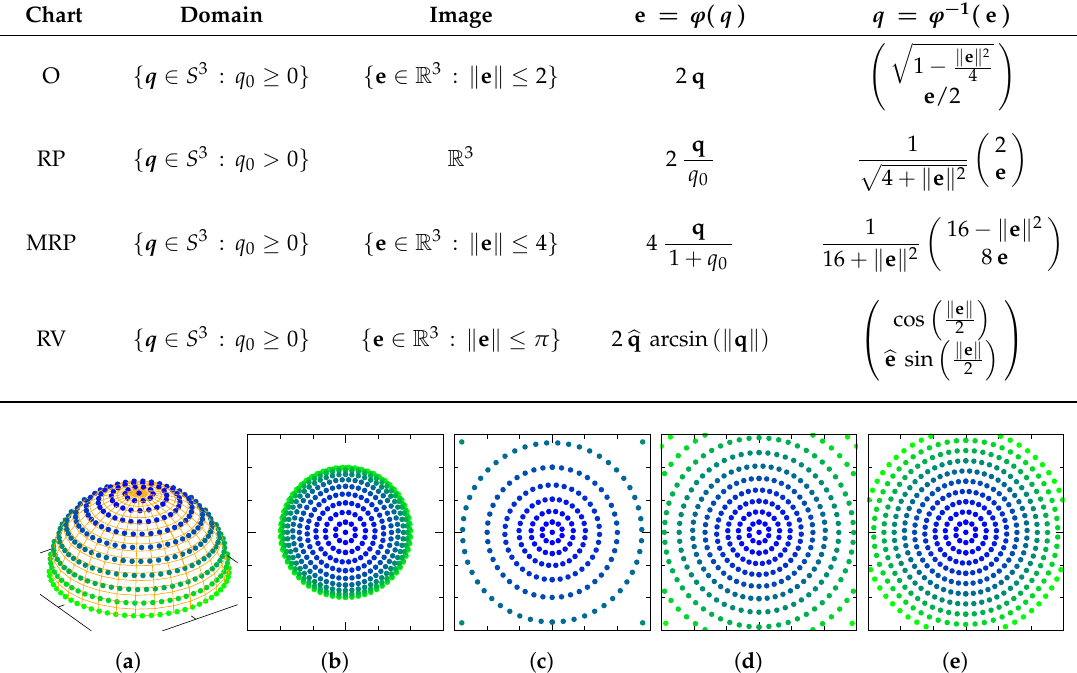
Table 2. Main characteristics of the charts studied.